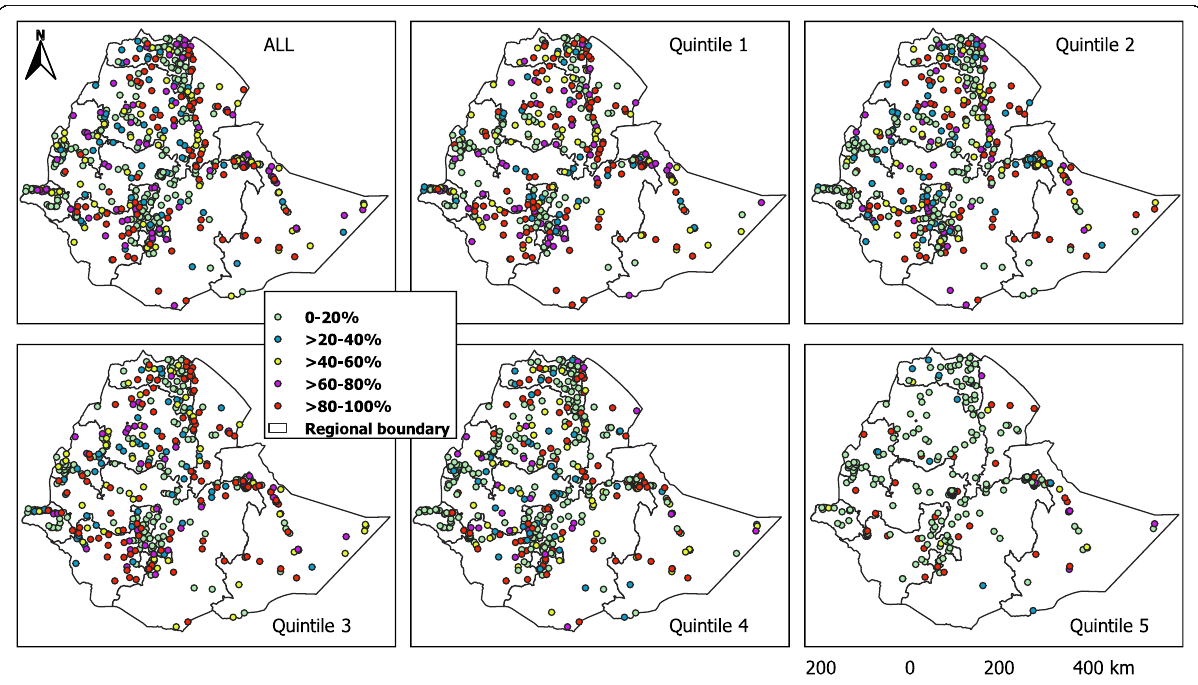
Fig. 3 Clusters categorized by the raw coverage rates of unimproved water for the overall population and by each quintile. Clusters with a higher percentage of unimproved water coverage were located at the North, South, and East part of the country. The red and pink colors indicate clusters with the highest percentage of unimproved water